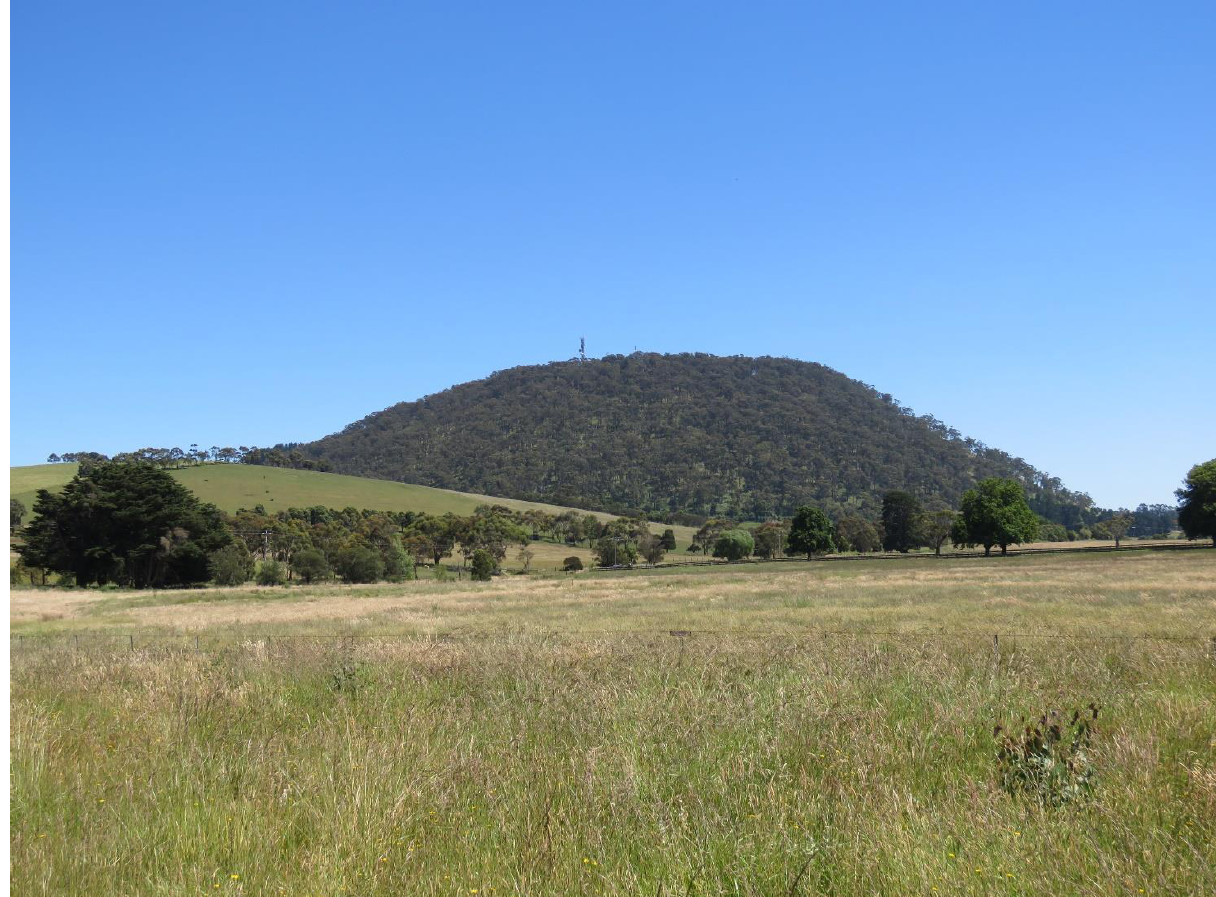
Figure 2. Bonan Youang/Mount Buninyong. Source: author.